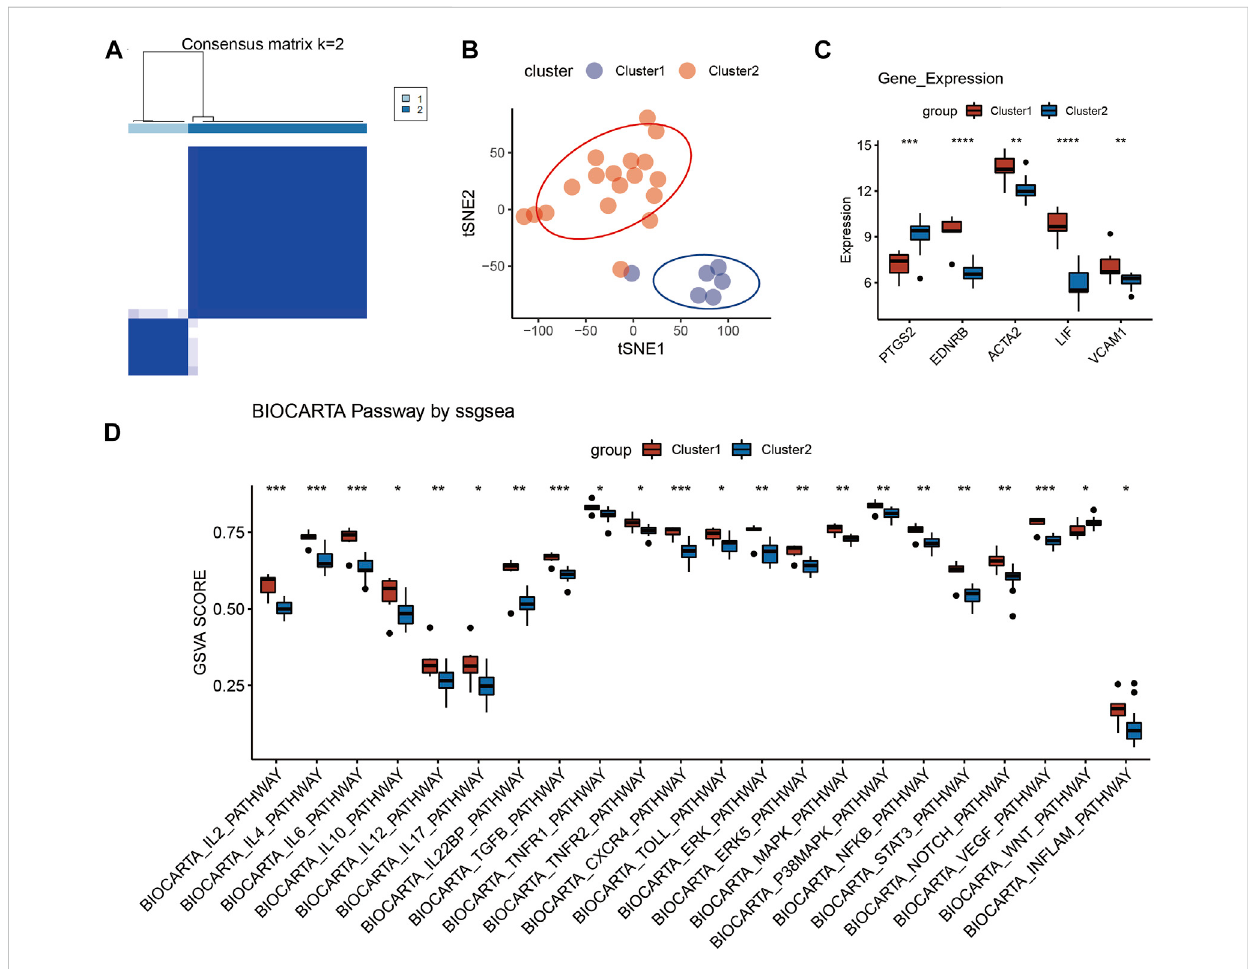
FIGURE 6 Identi fi cation of RIF subgroup in GSE111974. (A) Reordered consensus matrix on RIF compendium, by applying k-medoids with k = 2. (B) t-distributed Stochastic Neighbor Embedding (t-SNE) reduces the dimensions of a multivariate dataset. (C) Box plot reveals the expression of fi ve hub genes in the two clusters. (D) Box plot of BioCarta pathway analysis in the two clusters via ssGESA.